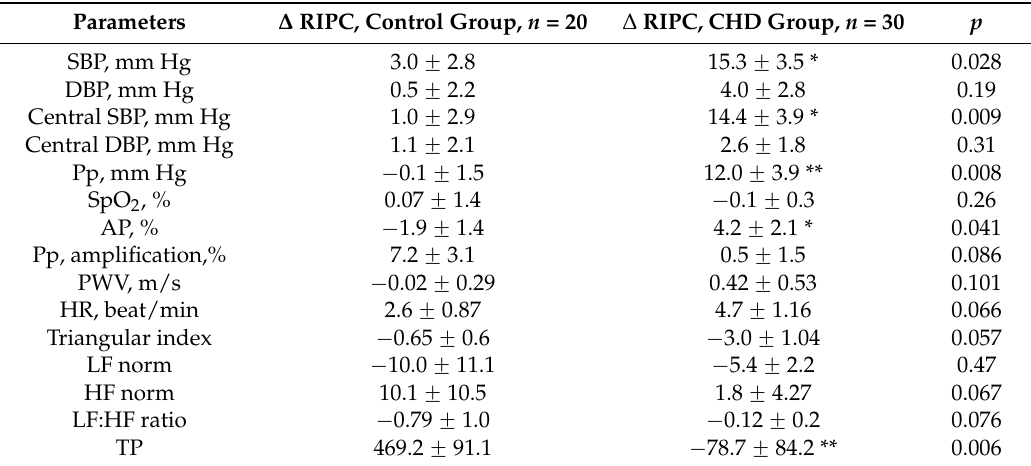
Table 4. Comparison of changes in the parameters in RIPC in the control and CHD groups. Parameters ∆ RIPC, Control Group, n = 20 ∆ RIPC, CHD Group, n =